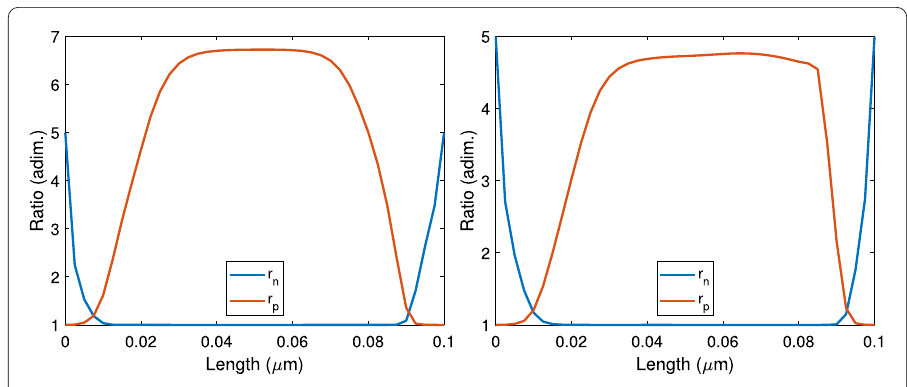
Figure 7 Ratios of the degenerate and non-degenerate diffusion coefficients in the case V b = 0.2 V and V G = –1.5 V (left) and V G = 1.5 V